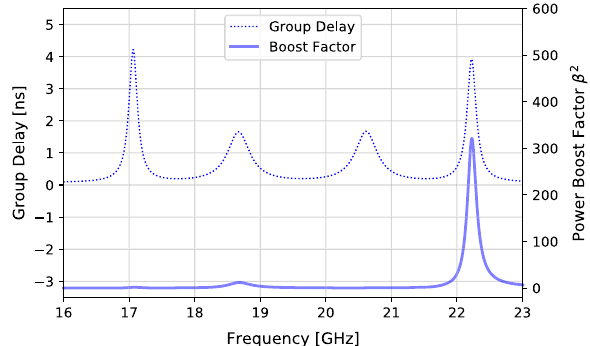
Fig. 3 Group delay and boost factor for a setup with 4 sapphire disks, each separated by 8mm, in the model with 50% antenna efficiency but without antenna reflections